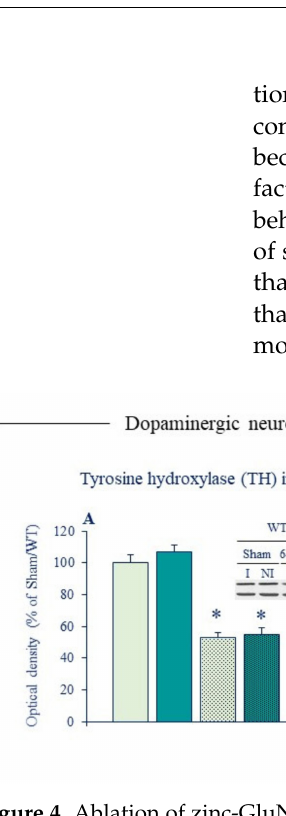
Figure 4. Ablation of zinc-GluN2A binding site has no impact on neurotoxicity and locomotor deficits of partial unilateral intrastriatal 6-OHDA lesion. ( A ) The left panel depicts the densitometric analysis of TH protein expression in the striatum of sham and lesioned male GluN2A-H128S KI mice and WT littermates ( n = 6–9 per genotype); western blotting analysis were performed in duplicates of the sample. The upper right panel depicts a representative blot of TH protein of injected (I) and non-injected (NI) striatal sides with β -actin as the reference. ( B ) Locomotor activity of sham and lesioned KI mice and WT counterparts tested in Actimetry cages. ( C ) Contralateral forelimb use of sham and lesioned male GluN2A-H128S KI mice and their WT counterparts in cylinder test. The dotted line indicates symmetric use of forepaws. Data expressed as mean ± SEM. * p < 0.05 vs. Sham/WT group, Fisher’s PLSD post-hoc test following a significant two-way ANOVA.